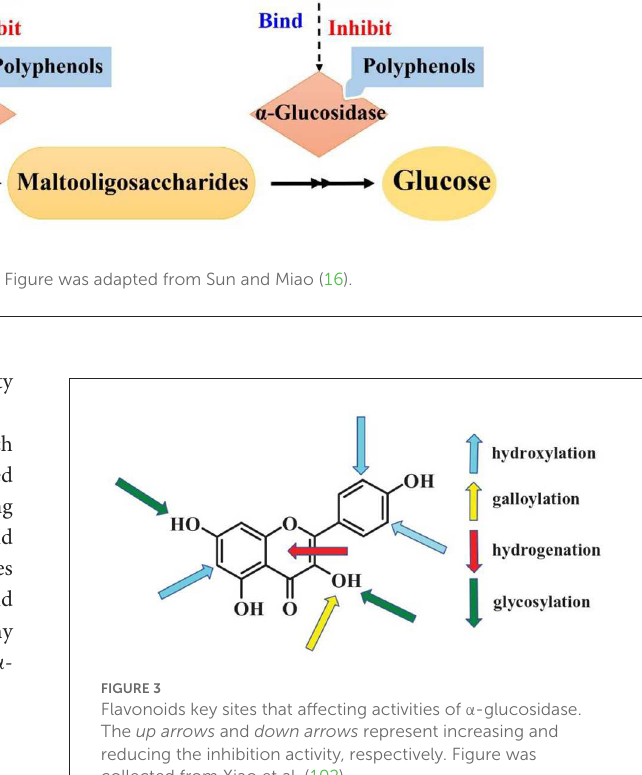
FIGURE3 Flavonoids key sites that affecting activities of α -glucosidase. The up arrows and down arrows represent increasing and reducing the inhibition activity, respectively. Figure was collected from Xiao et al.